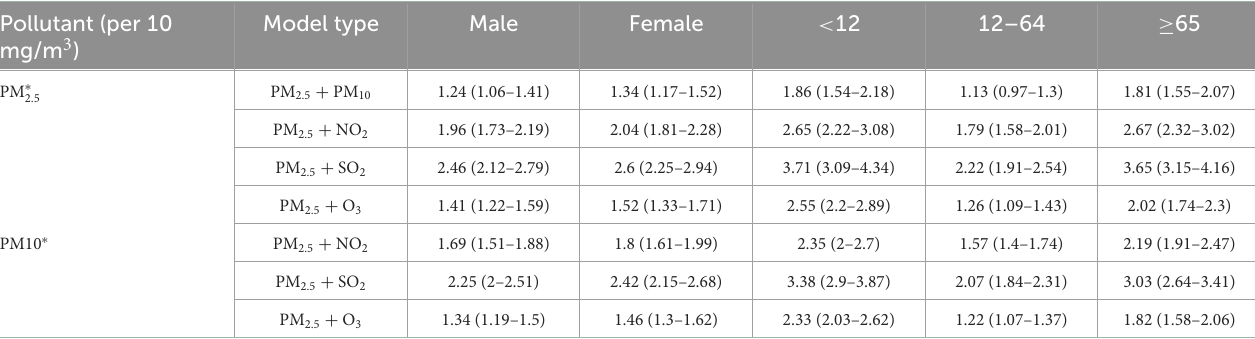
TABLE 7 Stratification analysis of the percent change of eczema risk associated with 10 mg/m 3 increase of PM 2.5 and PM 10 under two-pollutant model. Pollutant (per 10 mg/m 3